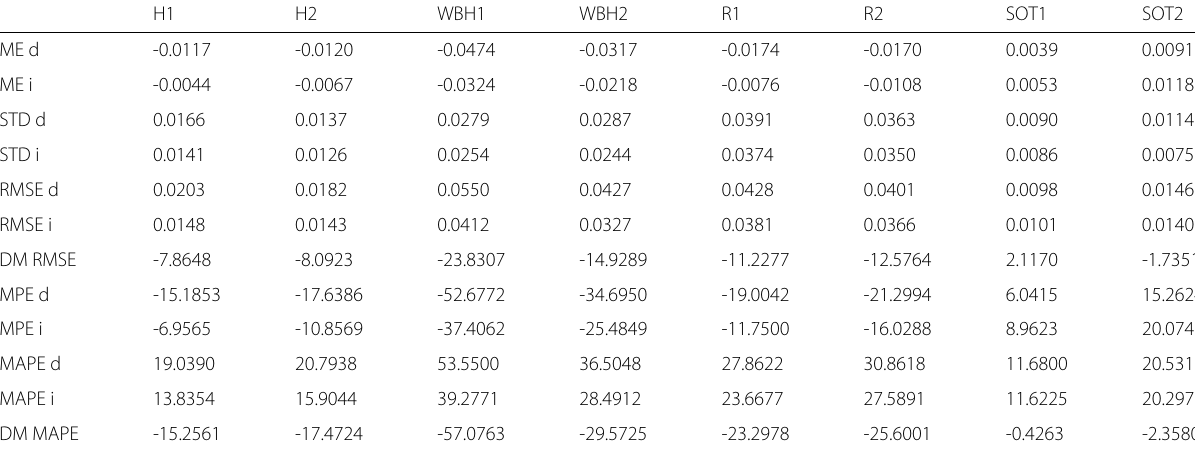
Table 3 Results for the prediction of route travel